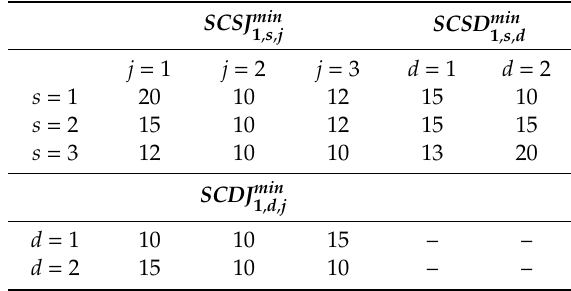
Table A18. Minimum loading capacity per shipment of product 1 (units).